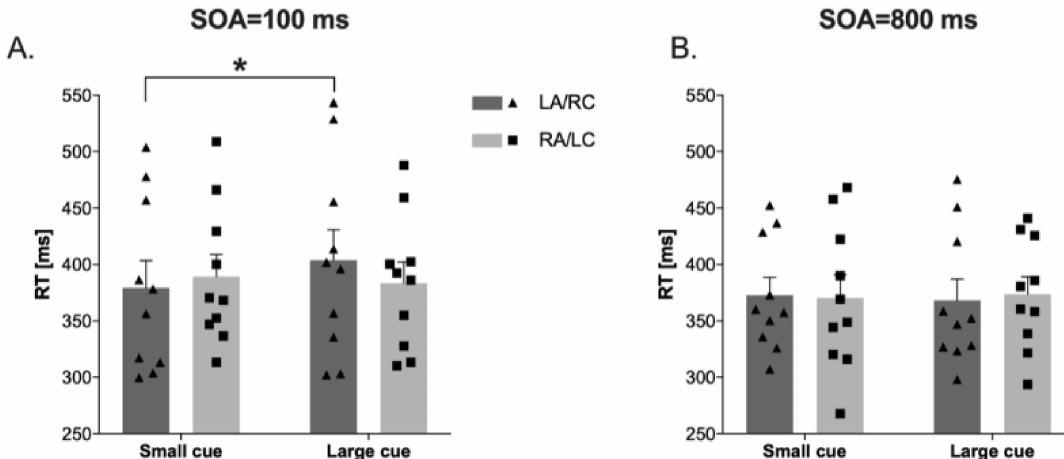
Figure 4. Reaction times (RTs) in attentional zooming task at 100 ms cue-target SOA (panel ( A )), and at 800 ms cue-target SOA (panel ( B )) in Left Anodal/Right Cathodal (LA/RC) and Right Anodal/Left Cathodal (RA/LC) conditions. Panel ( A ): RTs in large cue are significantly slower than small cue in LA/RC condition. Dots represent individual data points. * p <